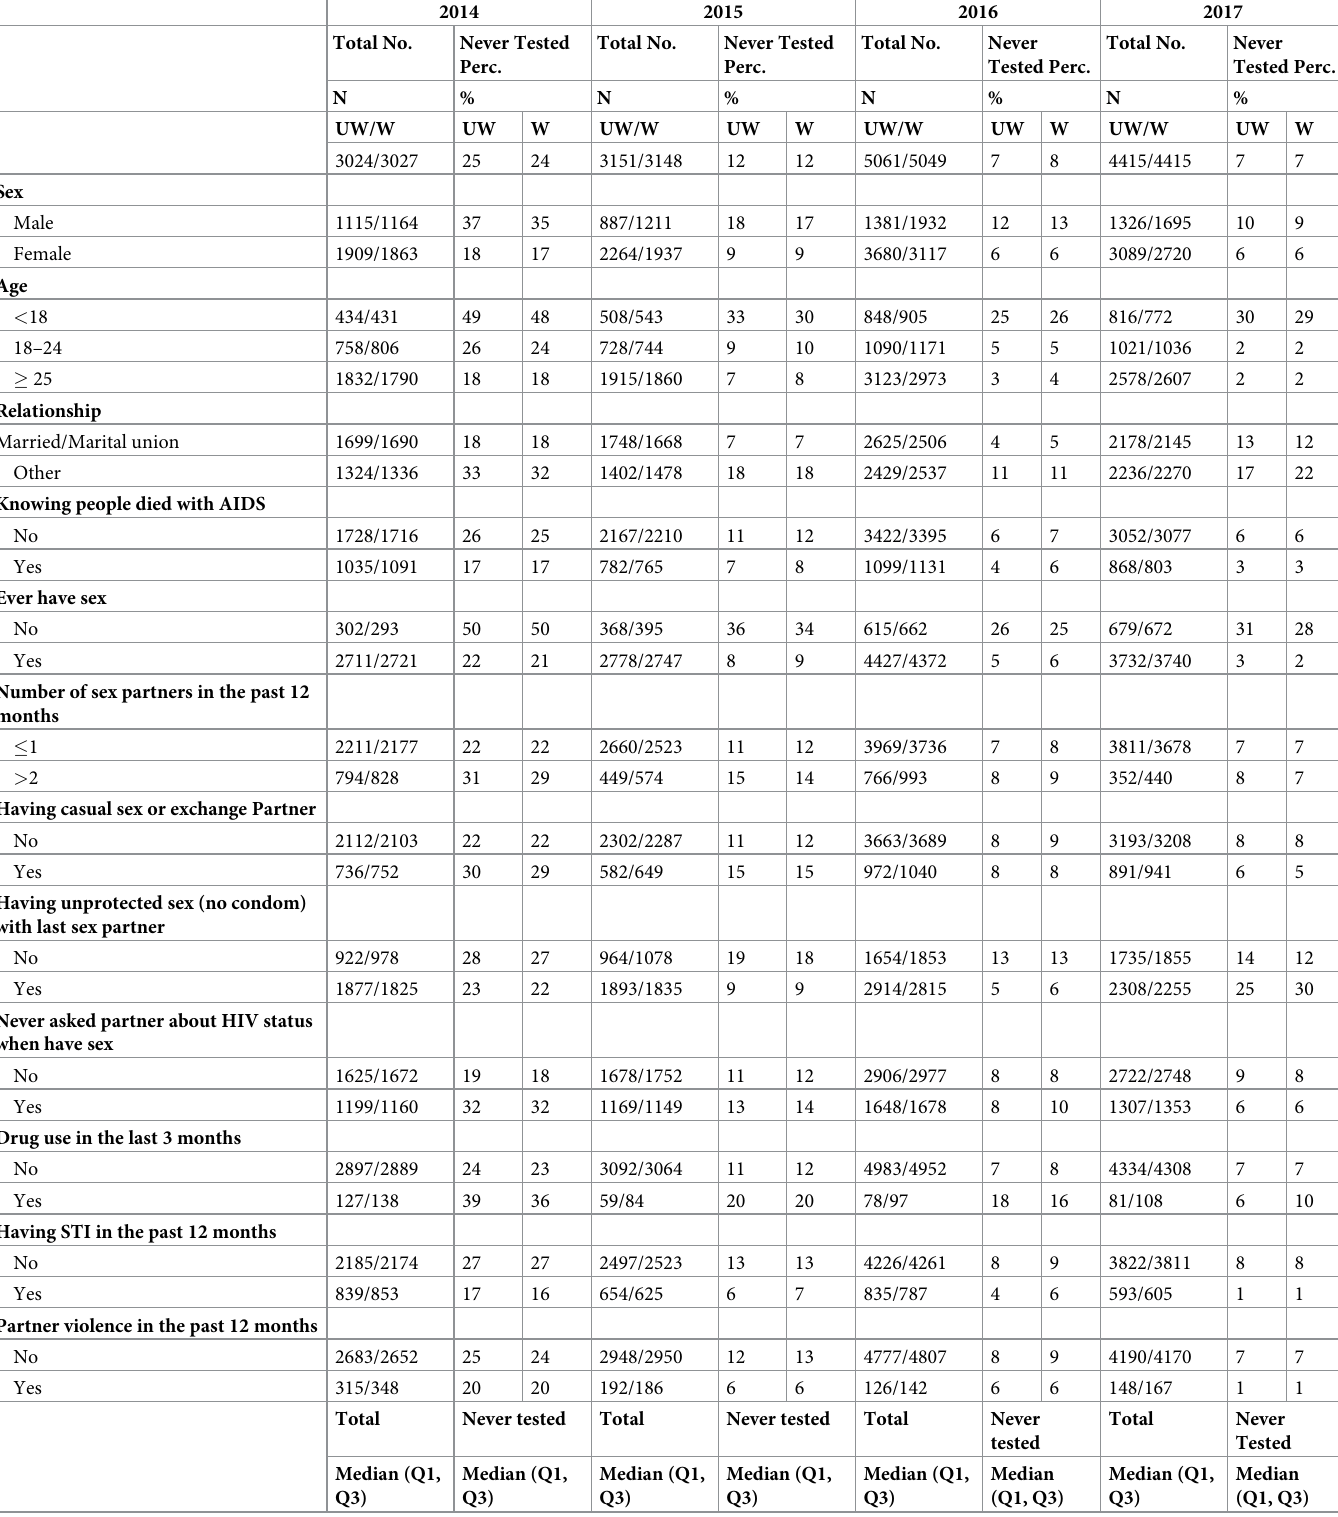
Table 1. Sample characteristics and proportions of participants never having been tested for HIV, by survey round